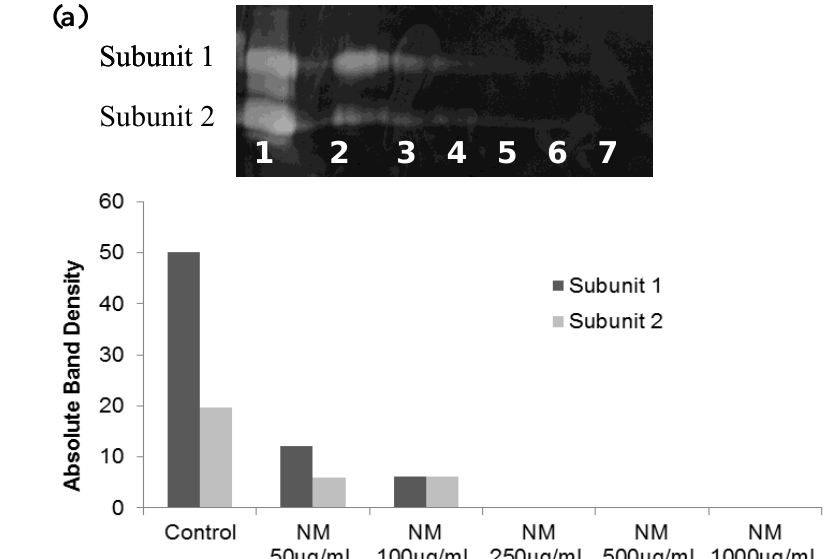
Figure 10. Effect of NM on SK-Hep-1 u-PA secretion ( a ) gelatinase zymogram;